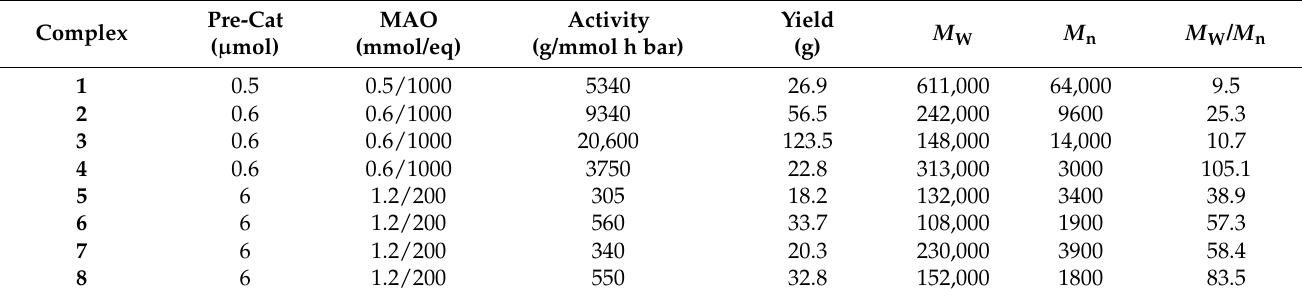
Table 1. Results obtained by Gibson et al. in the ethylene polymerization in solution 1